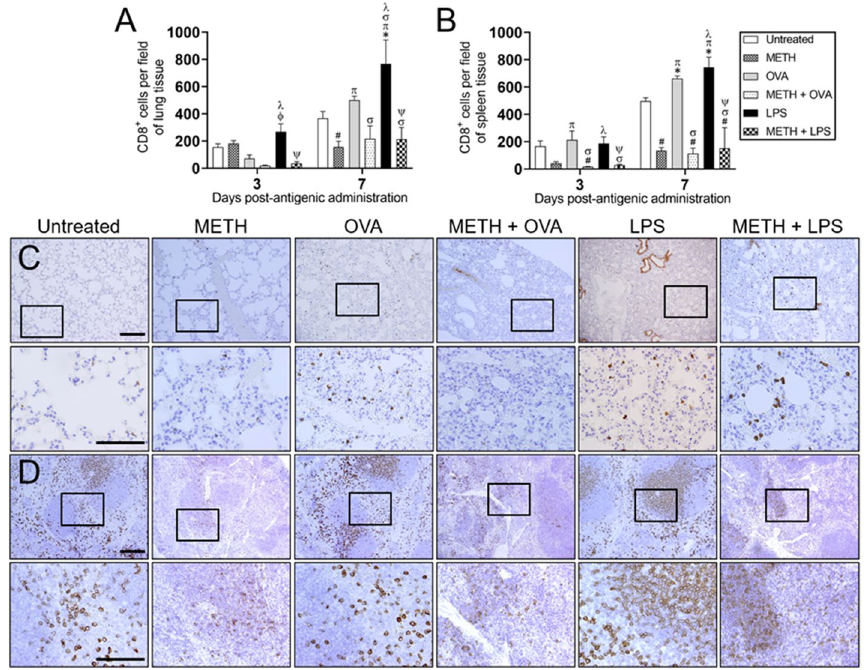
Figure 5. METH decreases CD8 + cell recruitment into murine tissues after OVA or LPS challenge. Counts of cytotoxic T (CD8 + ) cells per 0.1 g of (A) lung and (B) splenic tissue of C57BL/6 mice ( n = 5 mice per condition per day) 3- and 7-days post-METH and OVA/LPS administration were analyzed by microscopic counts. Bars indicate the average number of CD8 + cells ( n = 5 mice per condition per day) for untreated (PBS), METH, OVA, METH + OVA, LPS, and METH + LPS and error bars indicate STDEV. Symbols (*, π, , λ, #, σ, and ψ) indicate P value significance ( P < 0.05) calculated using ANOVA and adjusted by use of the Tukey’s post-hoc ϕ analysis. *, π, , and λ indicate significantly higher CD8 + cell infiltration than in the untreated, METH, OVA, and METH + OVA-treated groups, respectively. #, σ, and ψ indicate significantly lower CD8 + cell infiltration ϕ than in the untreated, OVA, and LPS-treated groups, respectively. Representative CD8 stained tissue sections of (C) lungs and (D) spleens excised from untreated, METH, OVA, METH + OVA, LPS, and METH + LPS-treated animals after 7 days post-Ag challenge are shown (scale bars for 10 and 60 × magnification, 100 μm). Brown staining indicates CD8 + cellular